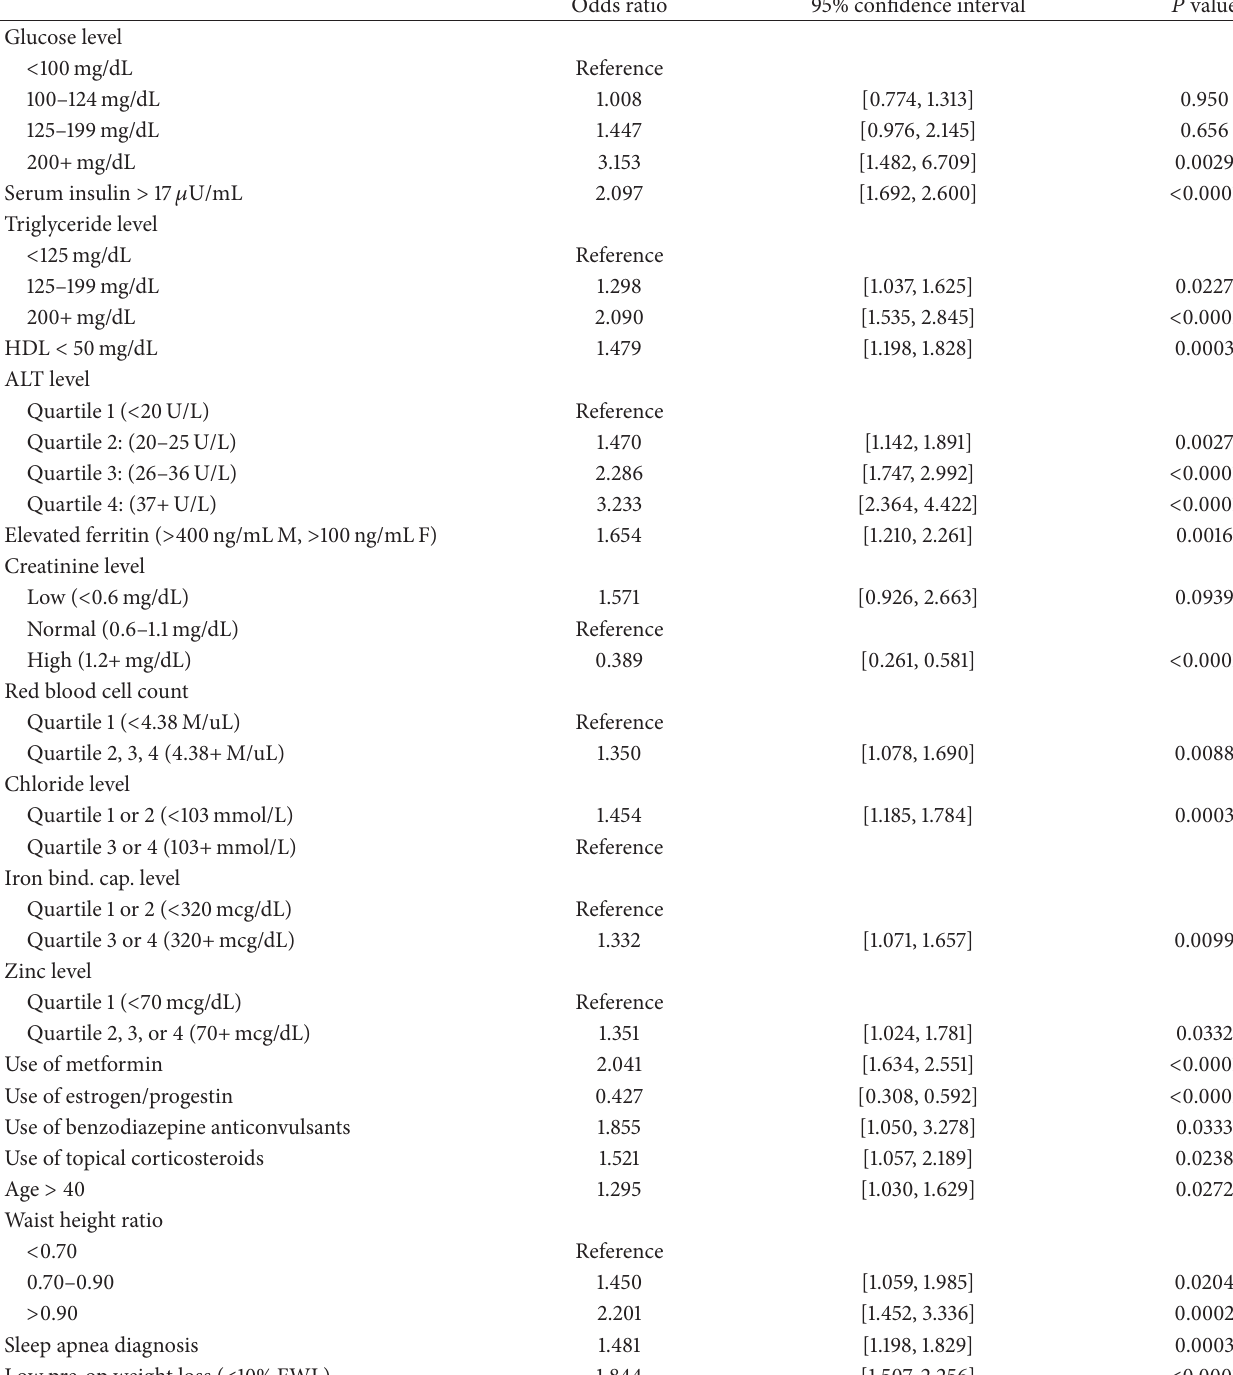
Table 2: Multiple regression results for presence of hepatic fat (grades 0, 1, 2, and 3 versus grade